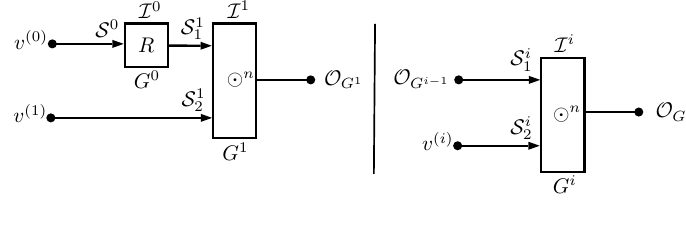
Figure 9: Stage 2 of Gadget δ ( ·